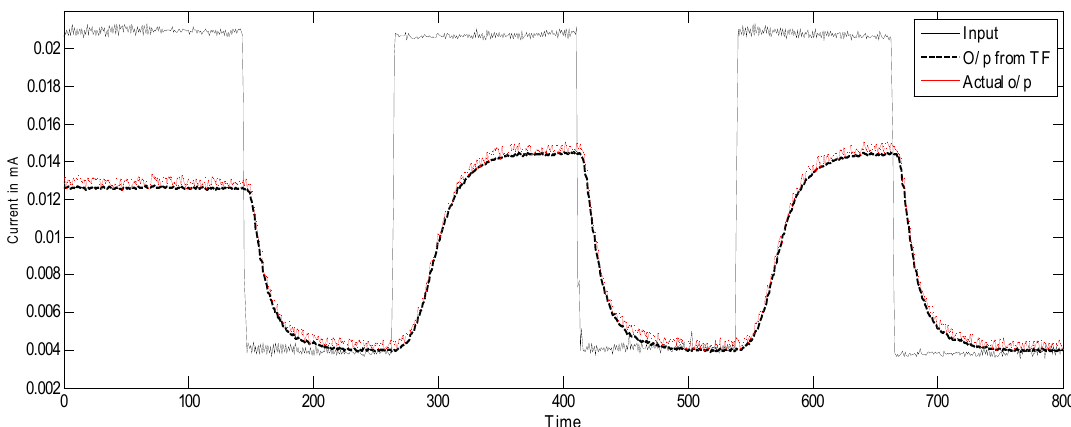
Figure 7. The response of the actual system and estimated transfer function.